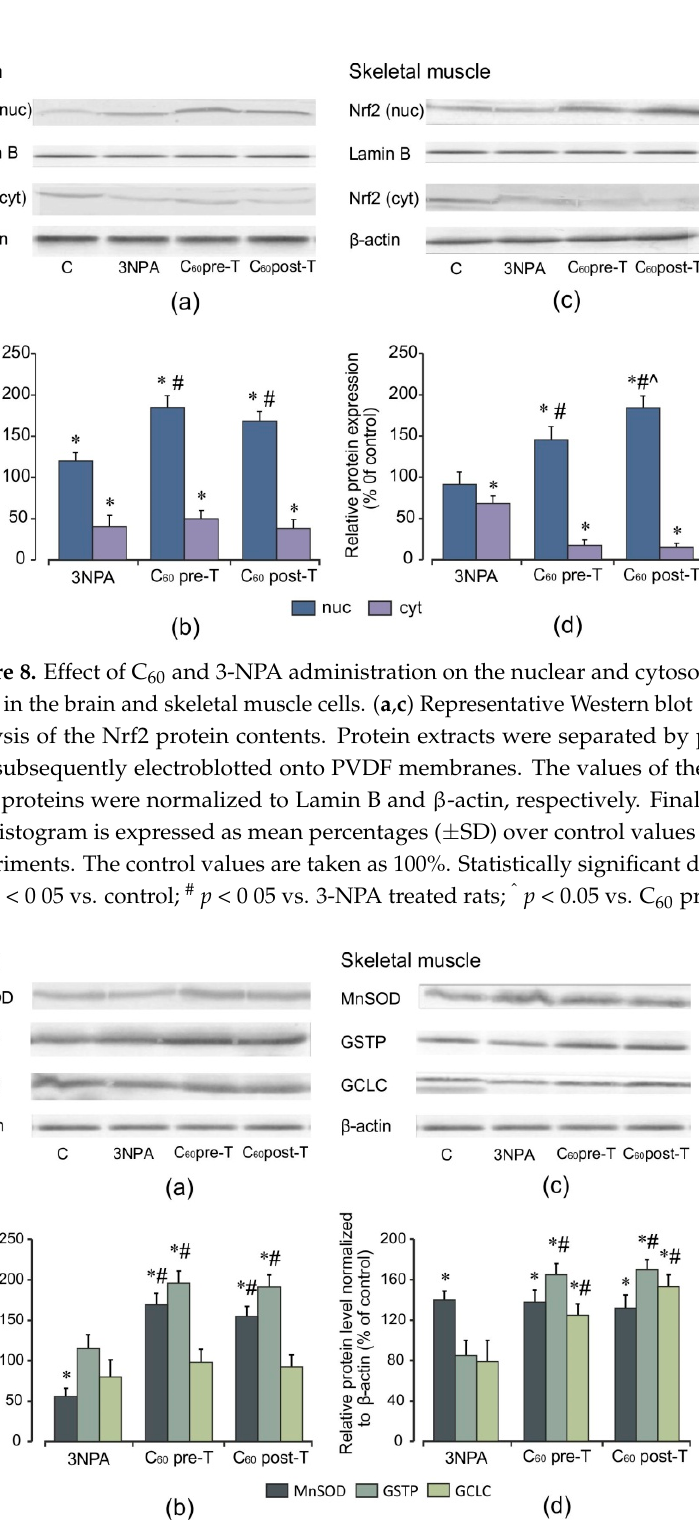
Figure 9. Effect of C 60 and 3-NPA administration on MnSOD, GSTP, GCLC protein expressions in brain and skeletal muscle mitochondria. ( a , c ) Representative Western blot and ( b , d ) densitometric analysis of protein levels. Protein extracts were separated by performing SDS PAGE and subsequently electroblotted onto PVDF membranes. The values of the proteins were normalized to β -actin. Final Western blot figure as the histogram is expressed as mean percentages ( ± SD) over control values from two independent experiments. The control values are taken as 100%. Statistically significant differences are indicated as * p < 0 05 vs. control; # p < 0 05 vs. 3-NPA treated